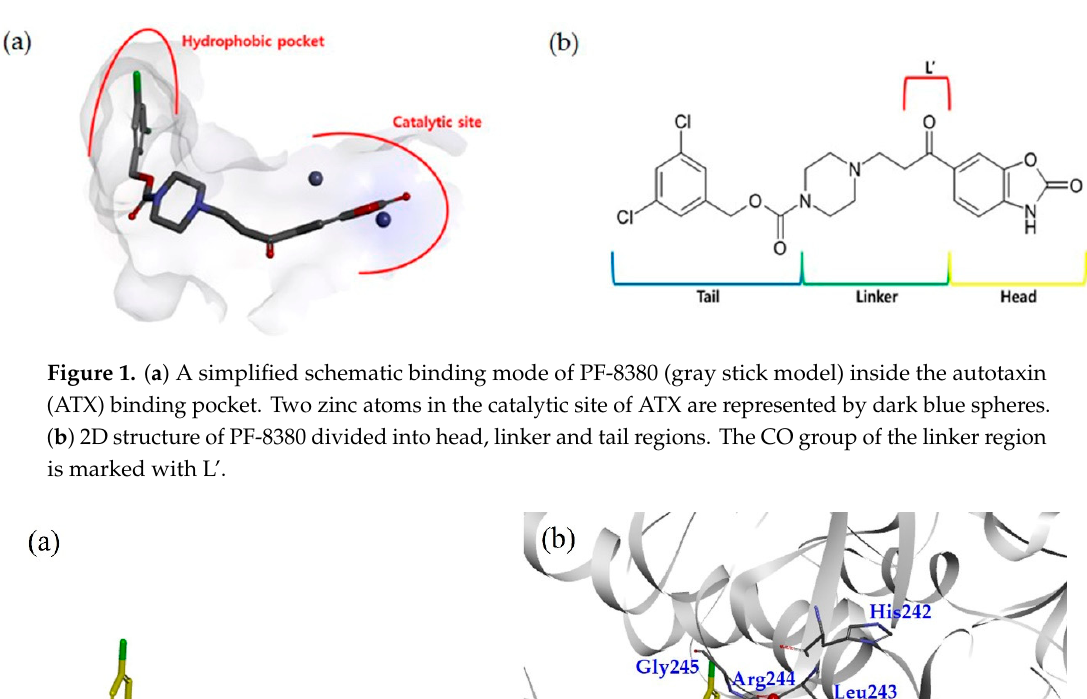
Figure 1. ( a ) A simplified schematic binding mode of PF-8380 (gray stick model) inside the autotaxin (ATX) binding pocket. Two zinc atoms in the catalytic site of ATX are represented by dark blue spheres. ( b ) 2D structure of PF-8380 divided into head, linker and tail regions. The CO group of the linker region is marked with L’.